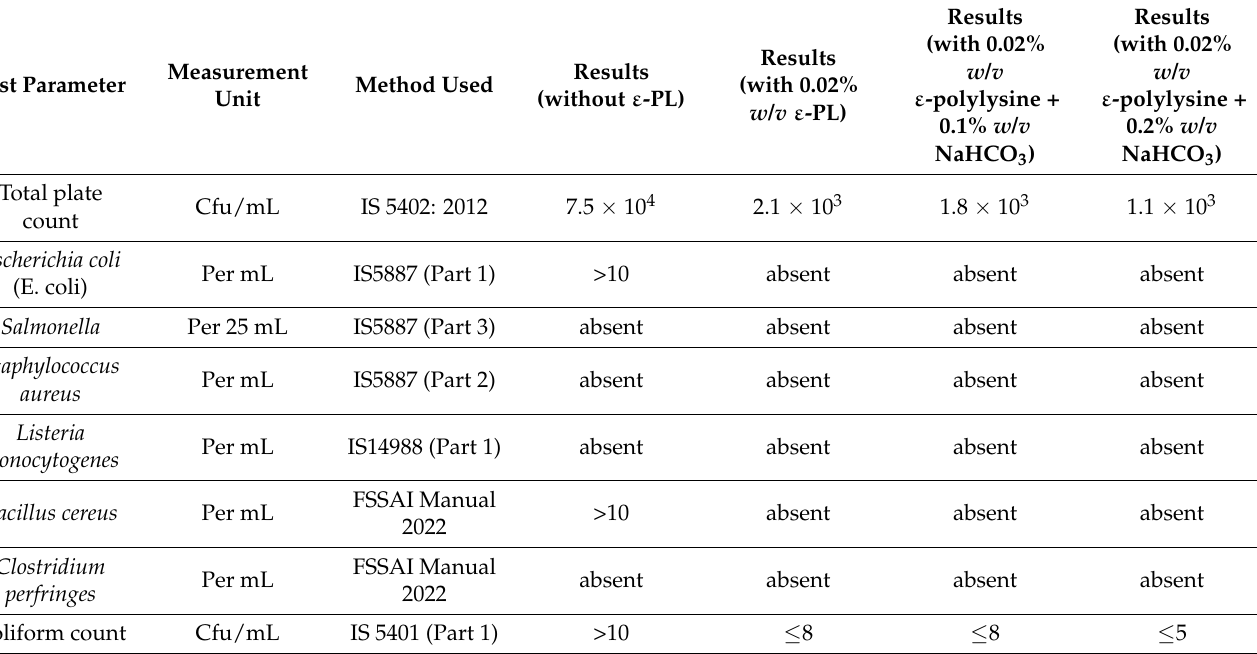
Table 4. Microbiological analysis of milk samples without ε -PL, with 0.02% w / v ε -PL, with 0.02% w /